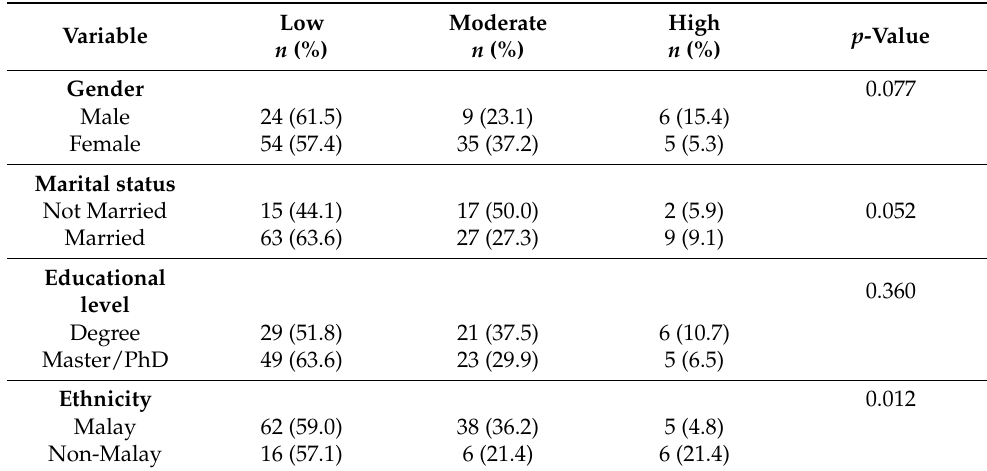
Table 5. Association between Marital Status, Educational Level, Ethnicity, Gender and Intention to Leave.